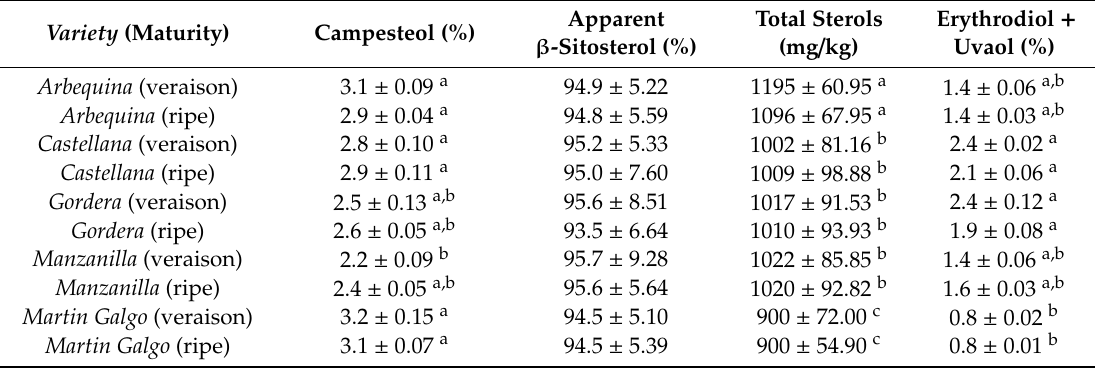
Table 4. Composition in the main sterols and triterpenic dialcohols of the samples of virgin olive oil analyzed, from the di ff erent olive varieties grown in the study area, collected at di ff erent stages of